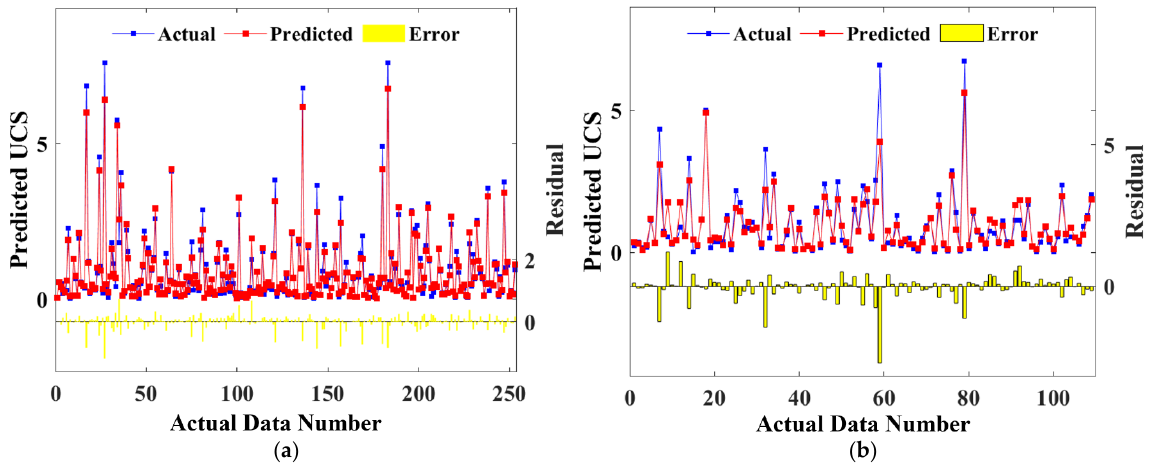
Figure 11. Comparison of predicted and actual values for training sets ( a ) and test sets ( b ).